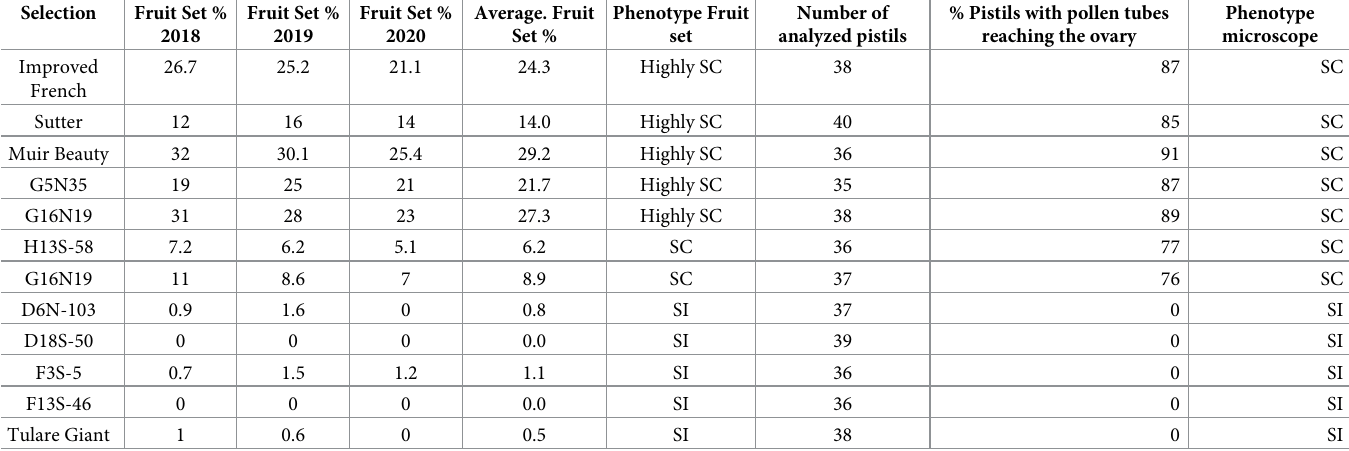
Table 2. Data showing fruit set after bagging and pollen tube growth for three years and phenotype for SC/SI from the evaluations in the field and in the lab under microscope observations.